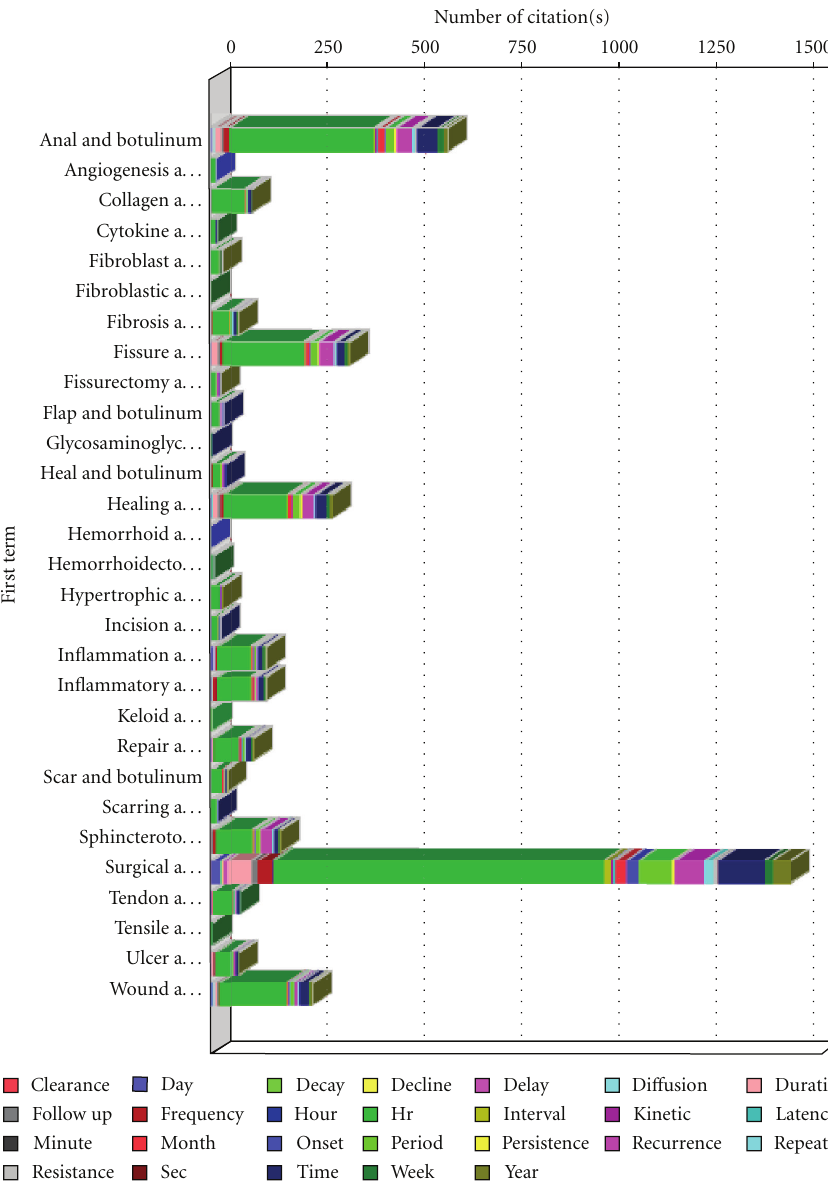
Figure 1: Example output from a botXminer database search. The numbers of botulinum toxin citations are shown for each of the combined 29 wound-healing (first term) and 26 time-related terms (legend) that were associated with 671 unique citations. The wound-related keywords associated with “botulinum” are associated with histograms that represent the di ff erent numbers of articles found in these multiple searches. The color-coded, time-related keywords used in these searches are simultaneously displayed in these histograms. Each “a ... ” in the left-hand labels signifies “and